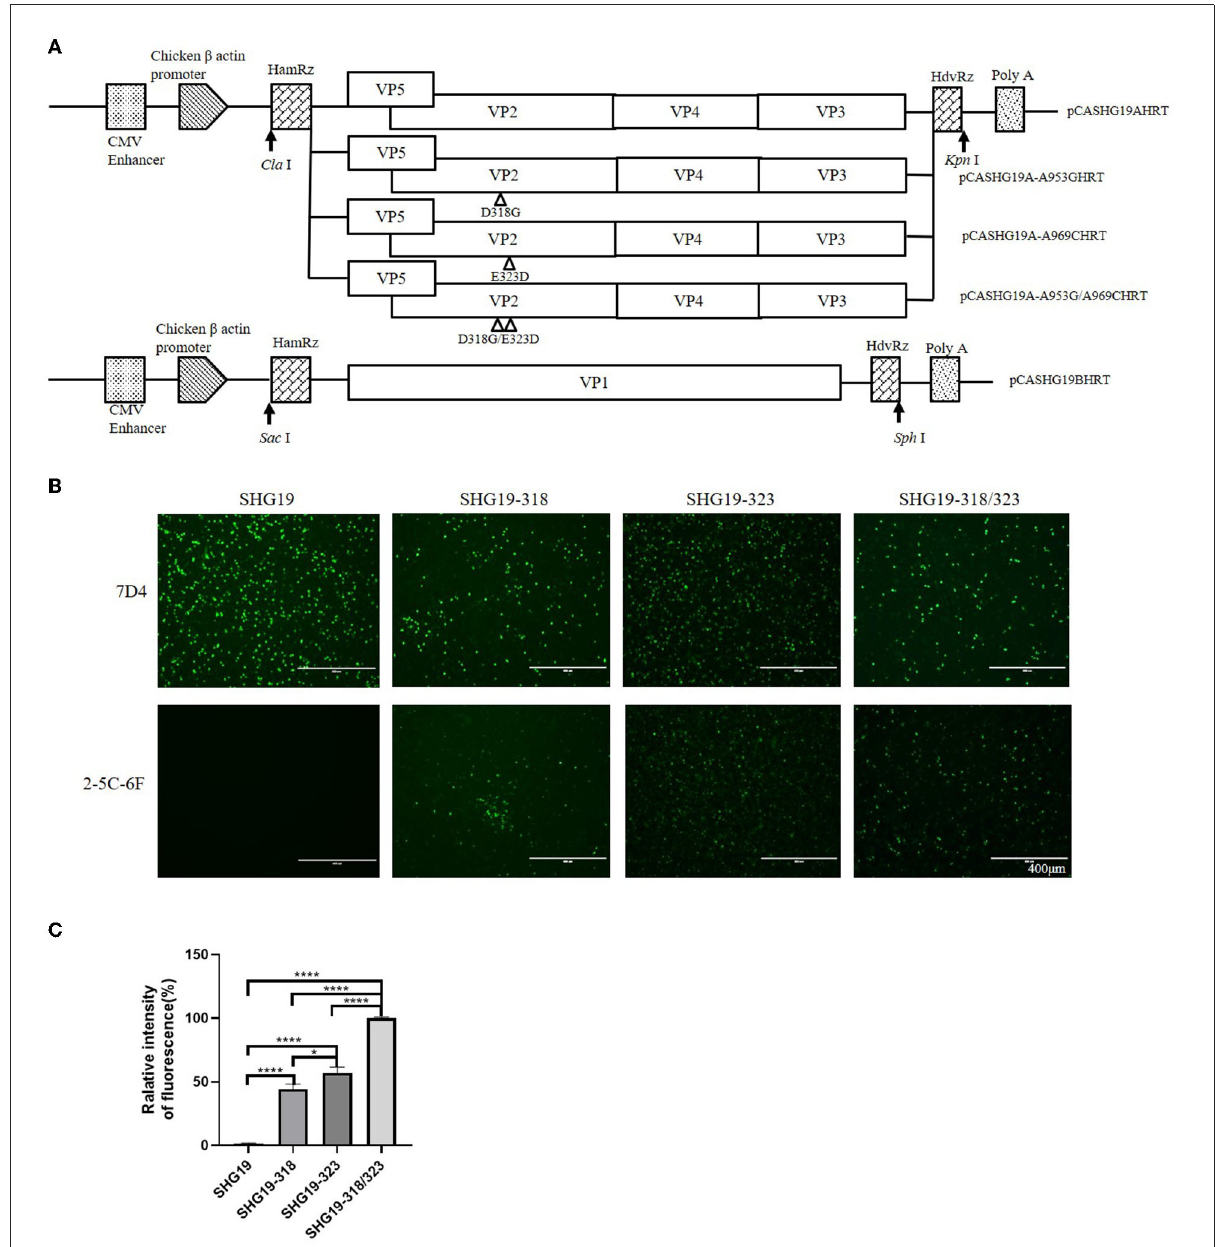
FIGURE5 Antigen recognition detection of the epizootic varIBDV SHG19 and its mutants in DT40 cells directed by MAbs 7D4 and 2-5C-6F. (A) Schematic diagrams of the infectious clones containing segment A and segment B of SHG19. In plasmid pCASHG19A-A953GHRT, pCASHG19A-A969CHRT, and pCSHG19A-A953G/A969CHRT, the nucleotide substitutions A953G, A969C, and A953G/A969C resulted in the amino acid substitutions D318G, E323D, and D318G/E323D of the VP2 protein of SHG19, respectively. The genomic cDNA sequences are preceded by a cytomegalovirus enhancer and a chicken β -actin promoter and are flanked by the cDNAs of hammerhead ribozyme (HamRz) and hepatitis delta ribozyme (HdvRz). The restriction enzyme sites used to construct recombinant vectors are also shown. (B) IFA of SHG19 and its mutants (SHG19-318, SHG19-323, and SHG19-318/323) on DT40 cells directed by MAbs 7D4 and 2-5C-6F at 24h post-infection. (C) Quantitative analysis of fluorescence. The mean fluorescence intensity and standard deviations (error bars) from three independent samples are shown. * represents P < 0.05, **** represents P <